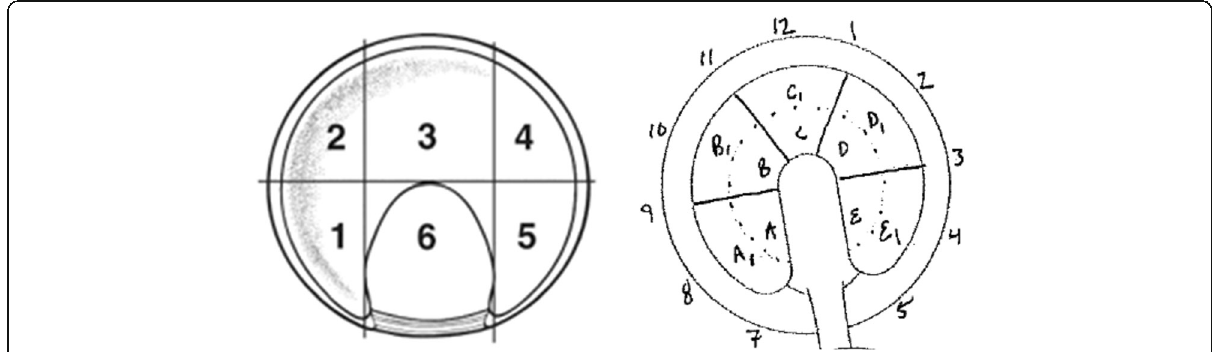
Fig. 2 Acetabular Chondral Lesion Classification Systems. The right hip zones for the geographic (left) and Method G (right) methods. Reprinted from Arthroscopy, 24 (5), Ilizaliturri, V. M. et al., A geographic zone method to describe intra-articular pathology in hip arthroscopy: